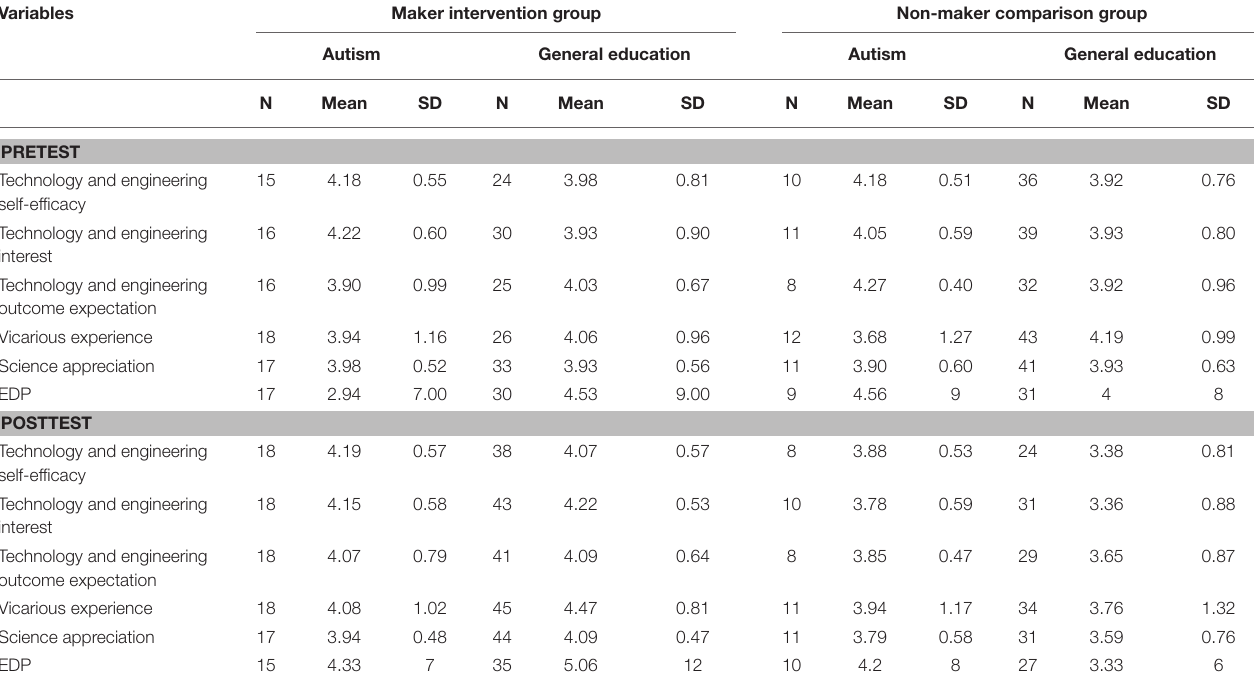
TABLE 2 | Pre-test and post-test scores by condition. Variables